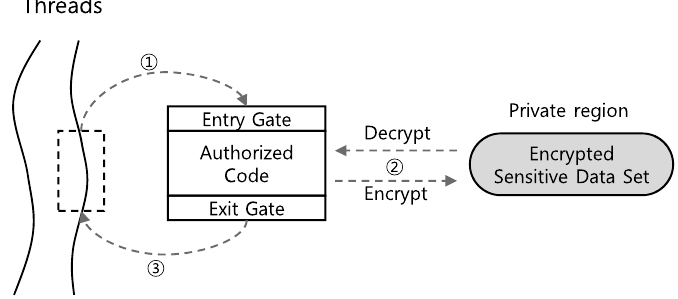
Figure 1. The data isolation mechanism of Sealer.